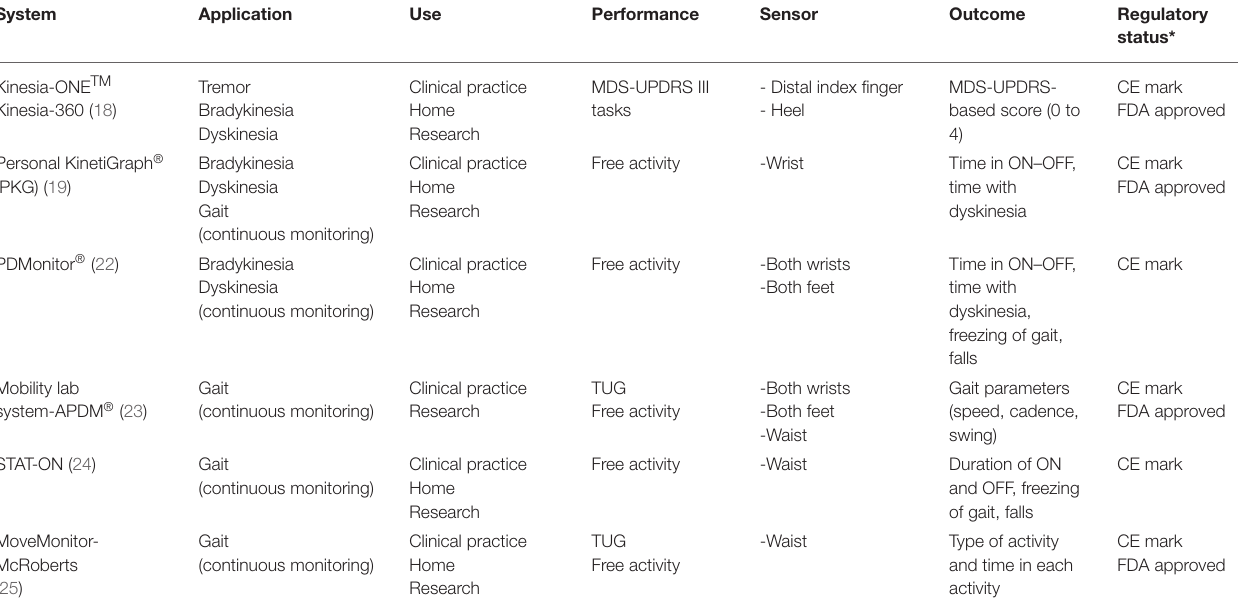
* As listed in the respective companies’ website or grey literature. The indication of use for each device as per CE Mark/FDA approval is linked to a specific clinical indication. Off-label use is not recommended. CE, Conformité Européenne; FDA, Food and Drug Administration; MDS-UPDRS-III, Movement Disorders Society-Sponsored Revision of the Unified Parkinson’s Disease Rating Scale; TUG, Time Up and